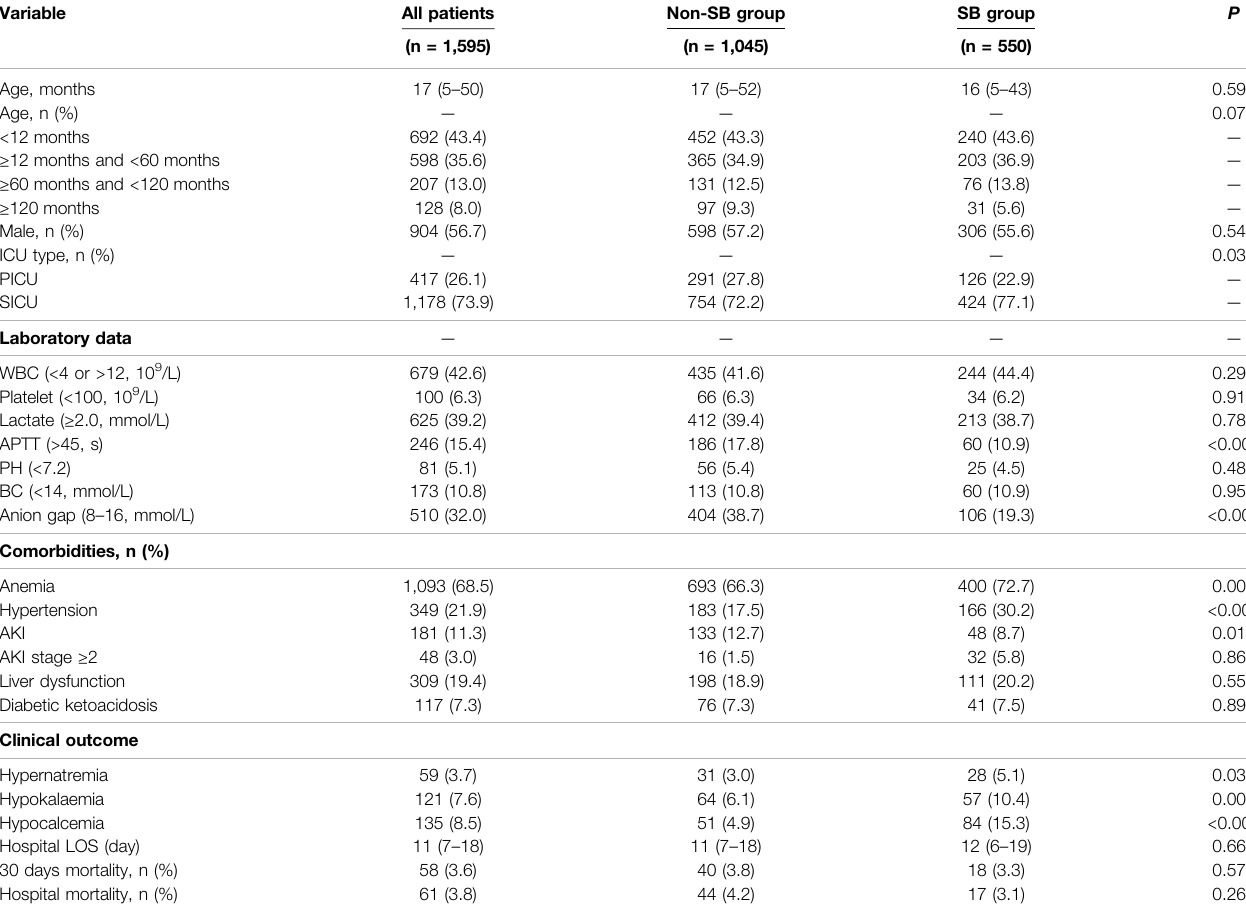
TABLE 1 | Comparisons of the baseline characteristics between patients with or without sodium bicarbonate use. Variable All